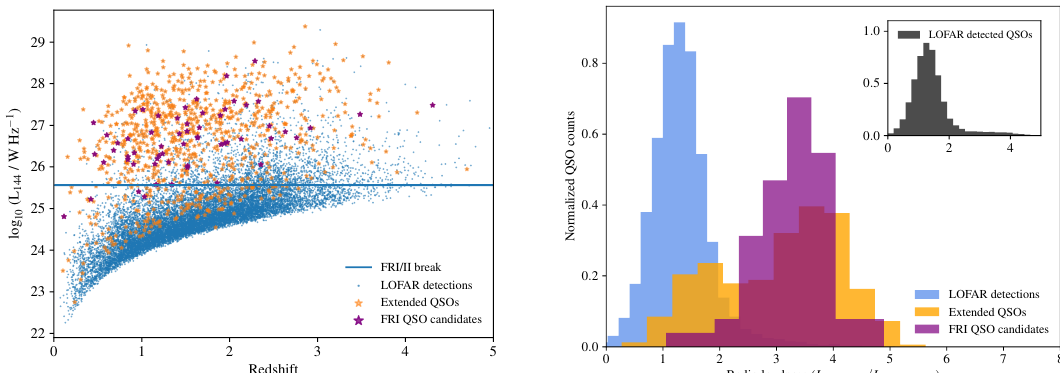
Figure 1. Left-panel : The distribution of 144-MHz luminosity of quasars as a function of their redshifts. Quasars detected in the LoTSS DR1 are shown as blue circles, sources showing extended (resolved in the LOFAR maps) emission are indicated by orange stars (these were obtained using the value-added catalogue) and our FRI quasar candidates (a subset of extended radio sources) are shown as purple stars. The blue solid line shows the traditional FRI/FRII break at 144 MHz. Right-panel : The radio loudness distribution of quasars (colour coded the same way as the left panel to show different classes) Inner panel shows the same histogram of all LOFAR detected quasars without dividing them into different classes (i.e., extended objects and FRI quasar